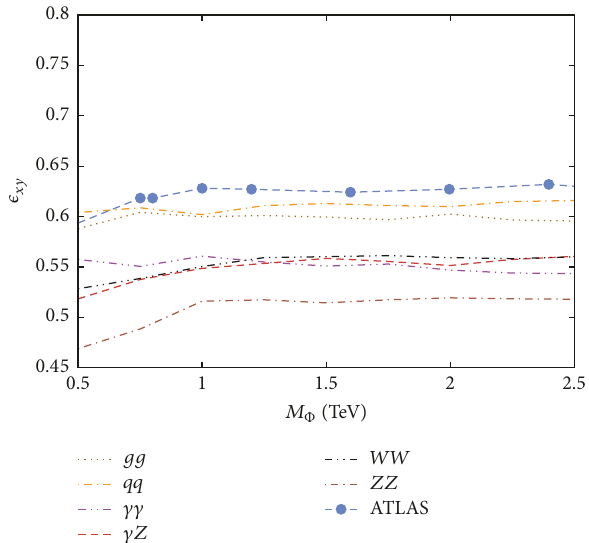
Figure 2: Cut efficiencies for different production modes as func- tions of 𝑀 𝜙 for the ATLAS selection cuts as defined in the text. The ATLAS cut efficiency (blue dots) is for a spin-0 resonance produced through the 𝑔𝑔 fusion